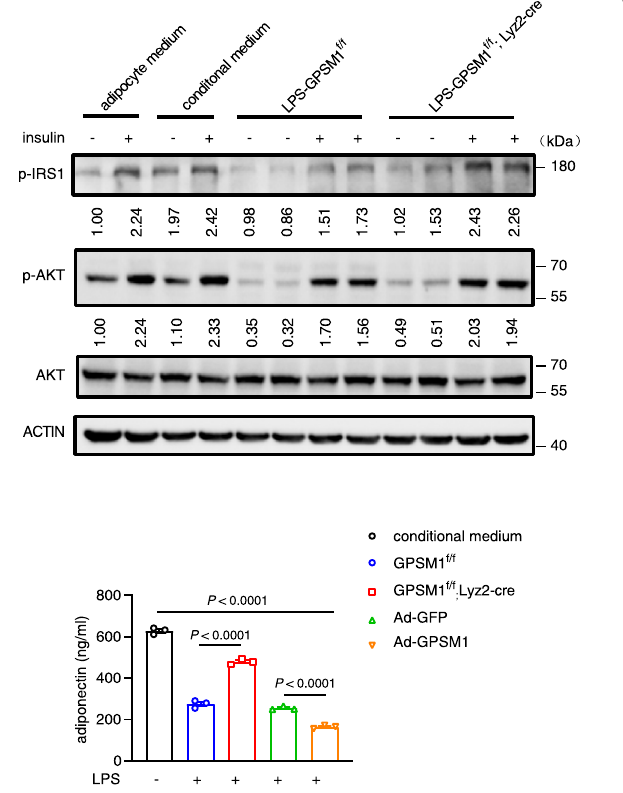
Fig. 8 | Macrophage GPSM1-driven in fl ammatory signal regulates co-cultured primary adipocytes insulin action and sensitivity. a Primary adipocytes were treated with conditioned media (CM) from LPS-primed GPSM1 f/f or GPSM1 f/f ; Lyz2 - CreBMDMs,vehicle-treatedBMDMs,andcontroladipocytemedium(freshmedia), for 48h. Protein expression levels of insulin signaling cascades, p-IRS1, p-AKT, and AKT after insulin (100nM) or vehicle stimulation for 15min were assessed using immunoblotting. b Primary adipocytes were treated with conditioned media (CM) from LPS-primed GPSM1 - or Con-overexpressing BMDMs, vehicle-treated